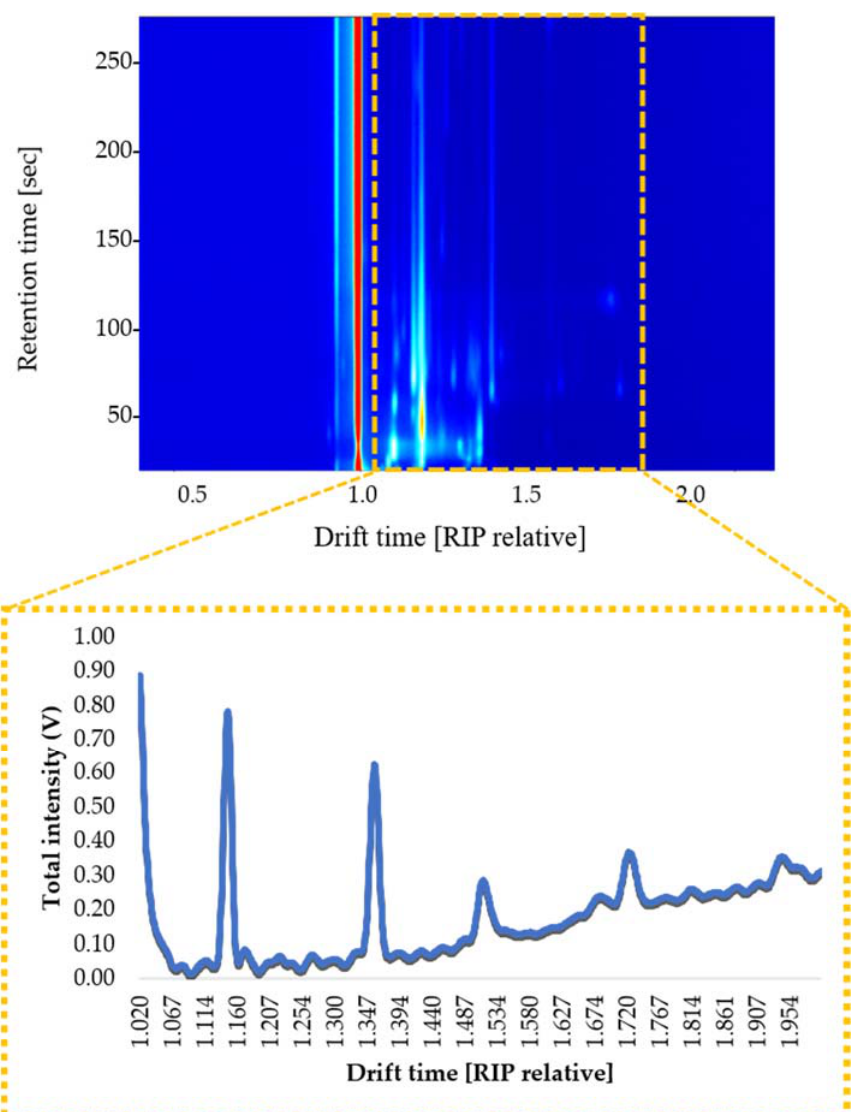
Figure 1. Topographic map of a gasoline-added water sample and ion mobility sum spectra (IMSS) obtained from the selected zone (yellow square).